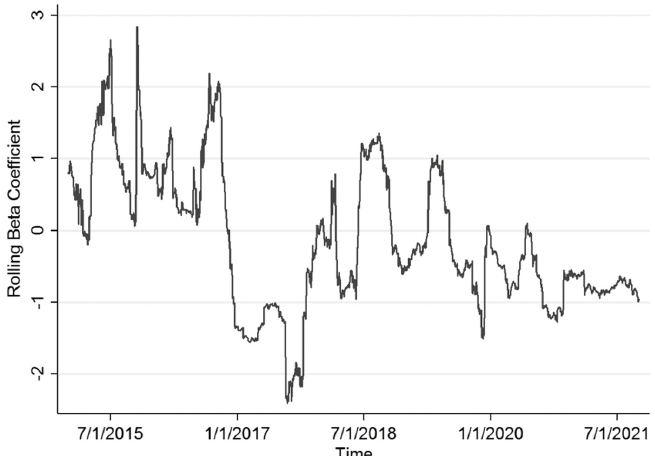
Figure 5. Common shock (rolling) impact on the Monte dei Paschi performance: period January 2015–